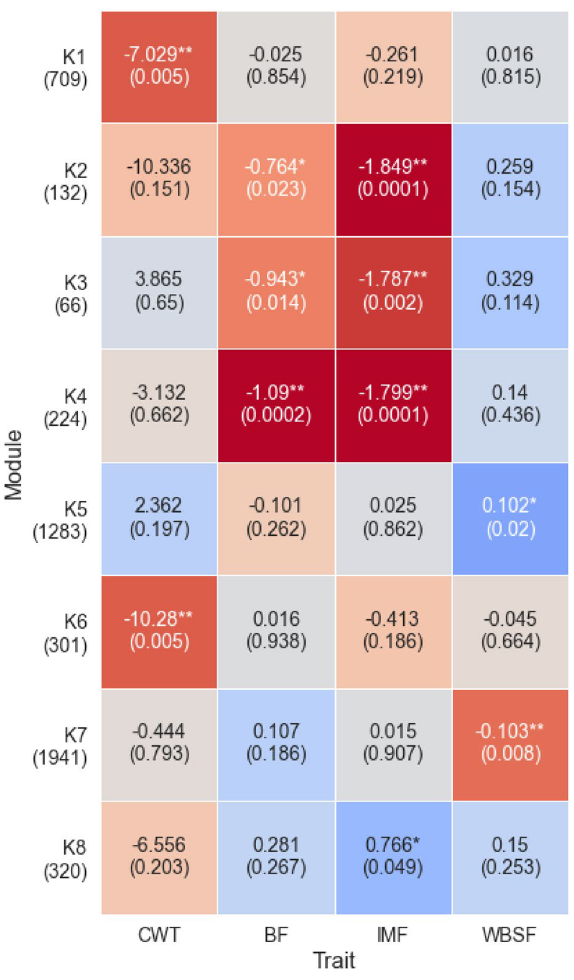
Figure 4. The DEM signals of modules defined by gmcNet. The y-axis shows the module names and numbers of genes within each module. The x-axis shows the complex traits. The numbers in each cell are regression coefficients (no parentheses) and the regression p -values (in parentheses). Red and blue indicate negative and positive coefficients, respectively. * p < 0.05 , ** p < 0.01